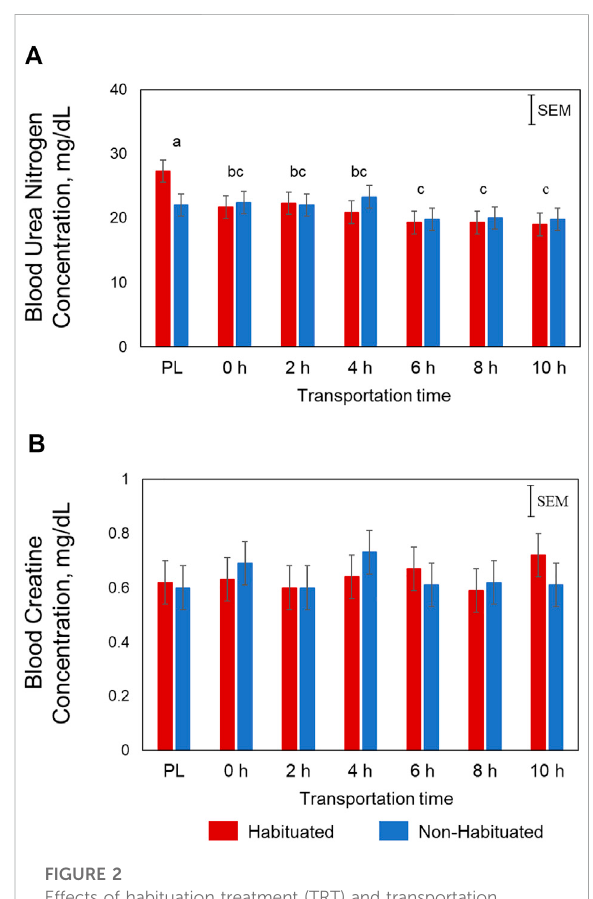
FIGURE 2 Effects of habituation treatment (TRT) and transportation time (Time; PL = Preload) on plasma (A) urea nitrogen (Time, p < 0.05), and (B) creatine concentrations in